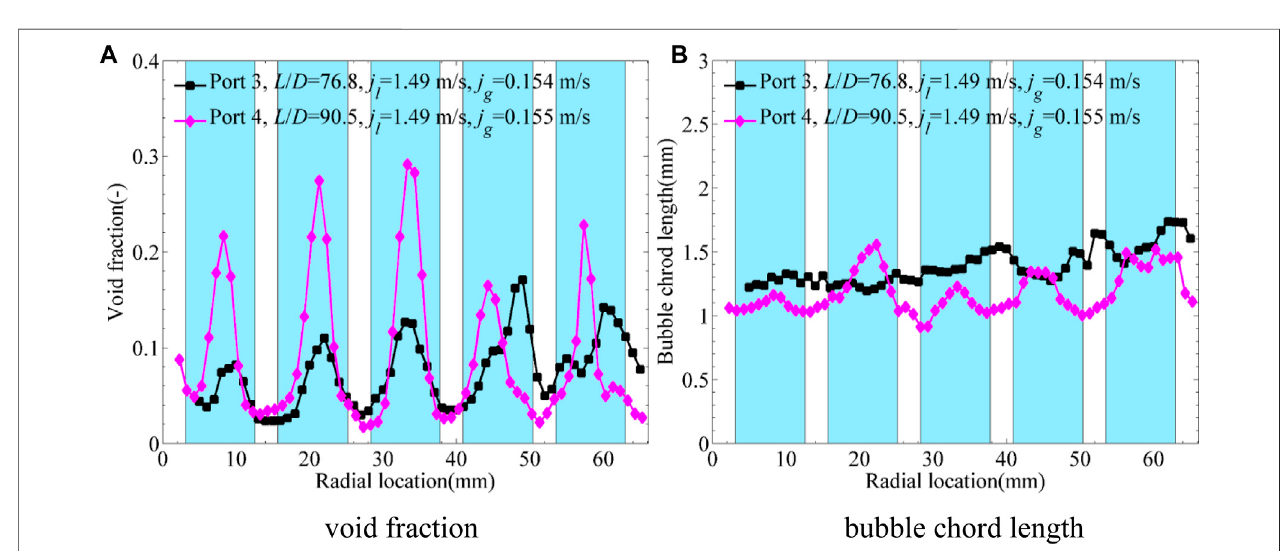
Frontiers in Energy Research |